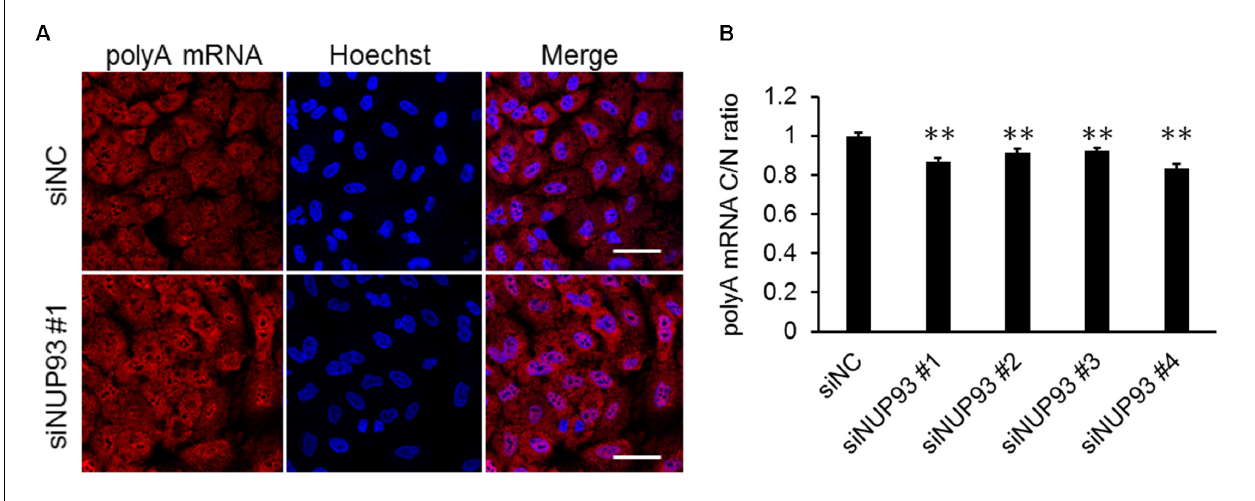
FIGURE 5 | Effect of NUP93 on host mRNA nuclear export. (A) siRNA-transfected cells were fixed and polyA mRNA was detected by fluorescence in situ hybridization. The images were obtained using confocal microscopy. Scale bars: 50 µ m. (B) Cytoplasmic to nuclear ratio (C/N) of polyA mRNA was determined in 200 cells for each condition. Values are means ± SE. ∗∗ p < 0.01 (one-way ANOVA followed by Dunnett’s test). The results are representative of at least three independent